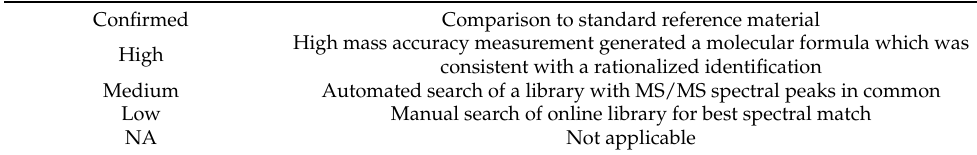
Table 3. Confidence Levels of Compounds Identified by LC–HRMS NTA.